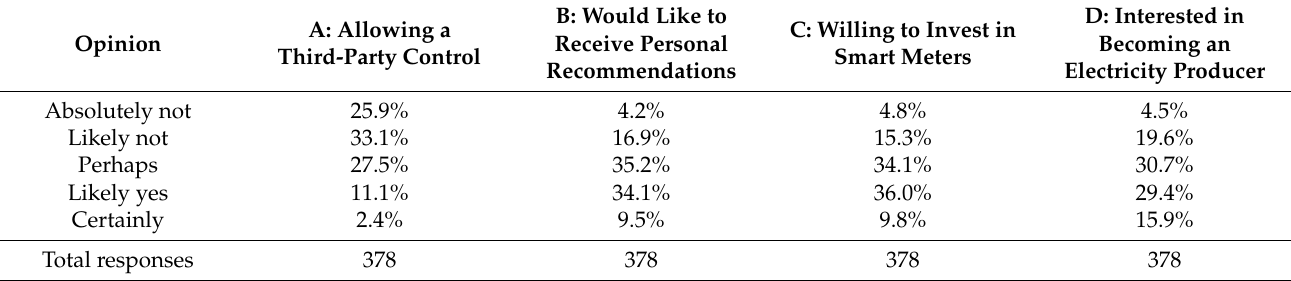
Table A7. The respondents’ opinions on energy-related suggestions.